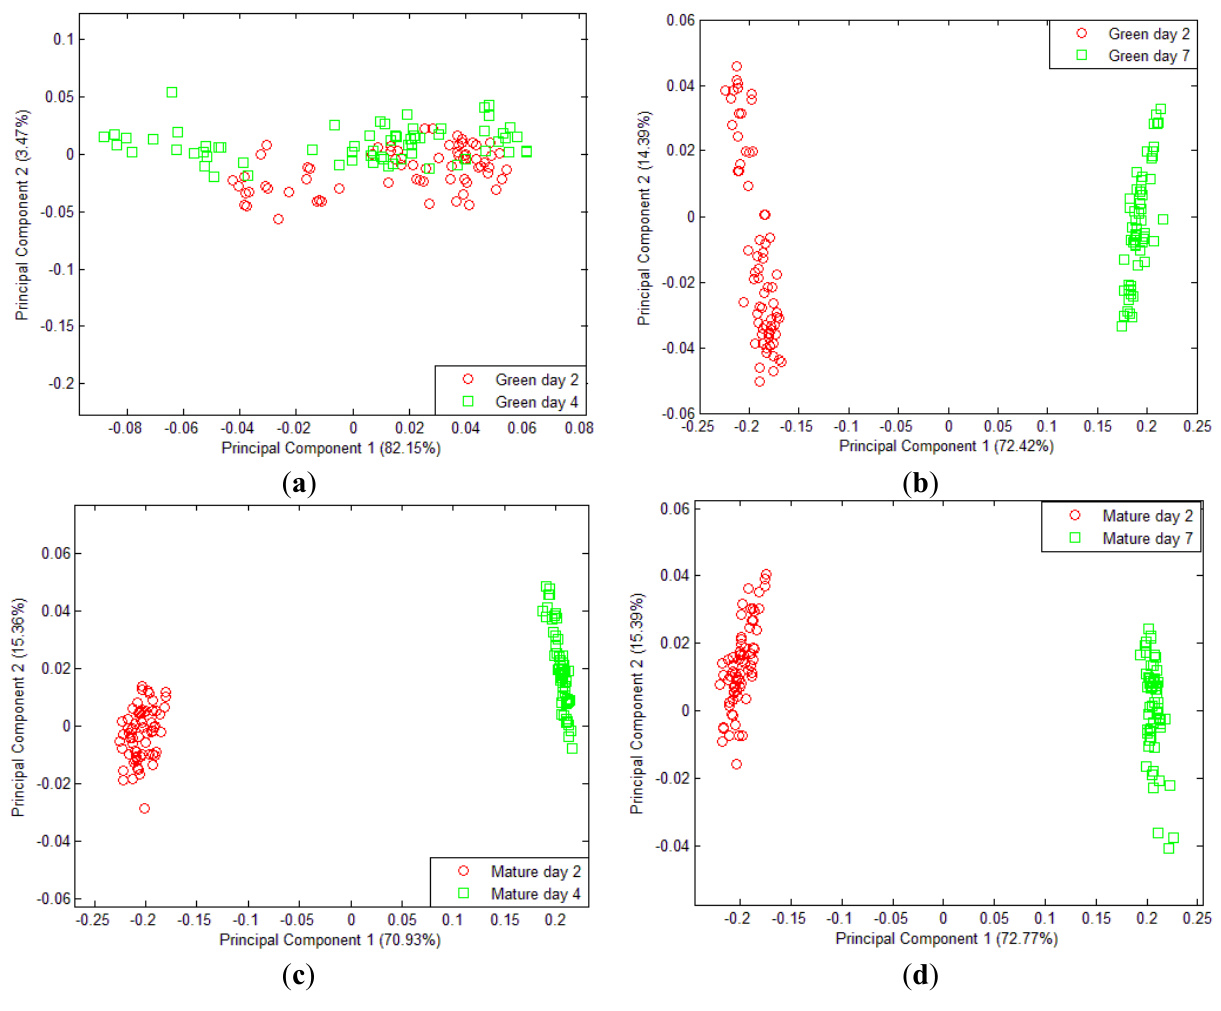
Figure 9. PCA plot of 32 mango sample ( a ) harvested at week 7 measured on day 2 and day 4, ( b ) harvested at week 7 measured on day 2 and day 7, ( c ) harvested at week 8 and measured on day 2 and day 4 and ( d ) harvested at week 8 and measured on day 2 and day